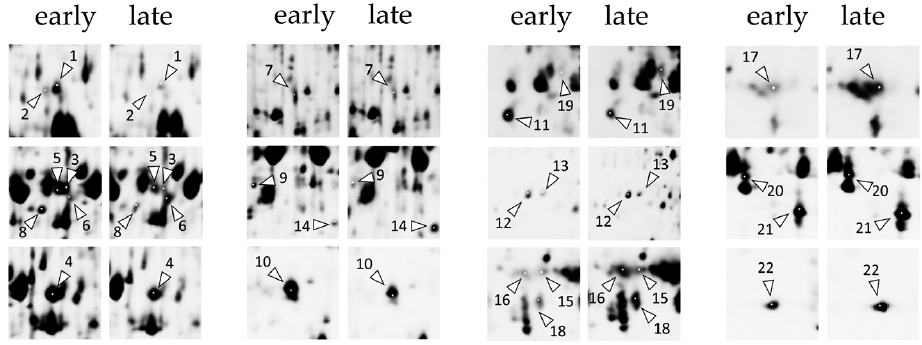
Figure A2. Comparison of differentially expressed proteoforms between timentin-treated tobacco in vitro shoot samples collected at the early and late stage (after one and three weeks of cultivation, respectively) of the propagation cycle. Arrows indicate protein spots identified by mass spectrometry and the spot numbers correspond to proteoform numbers in Table 1. Data shown are representative of four biological replicates.